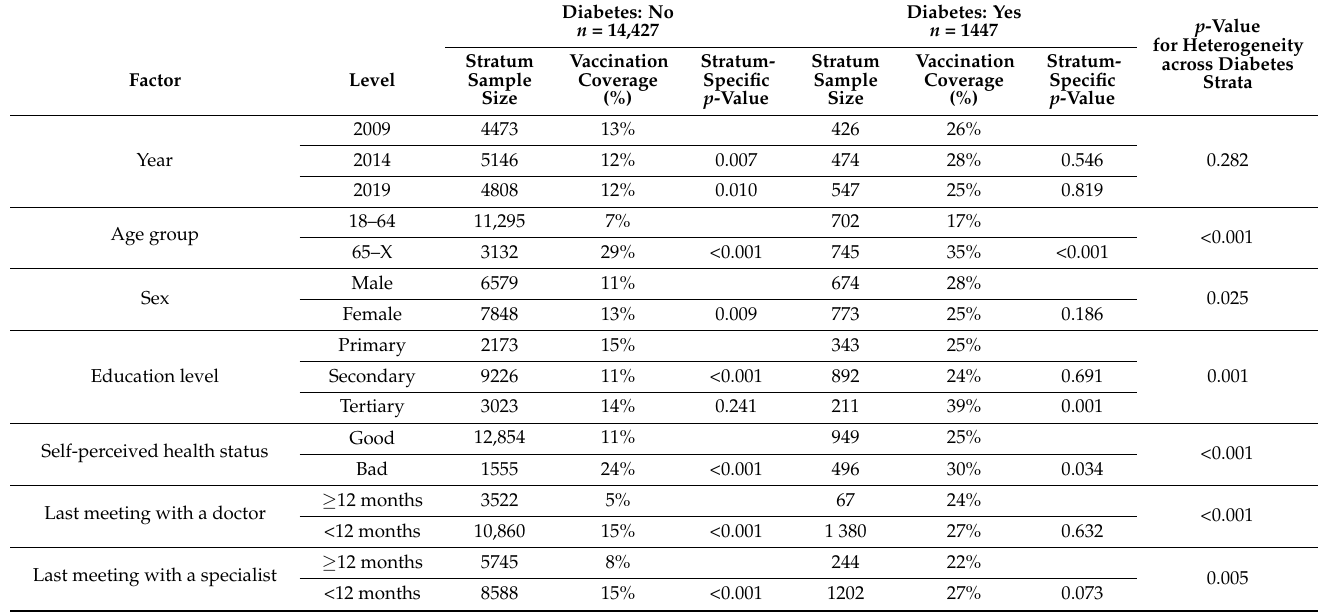
Table 1. Descriptive statistics by vaccination coverage of diabetic survey respondents. Diabetes: No n =